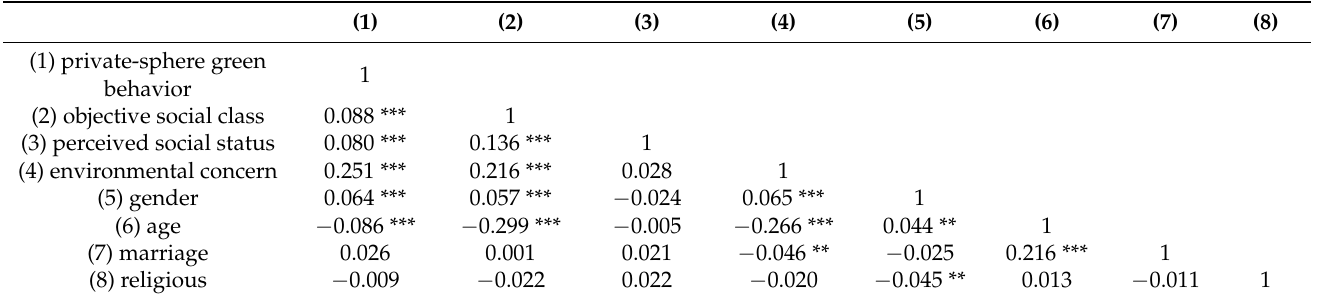
Table 2. Correlations matrix.